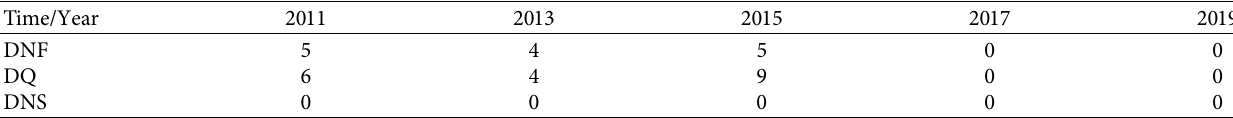
Table 6: Fouls in each competition from 2011 to 2019.